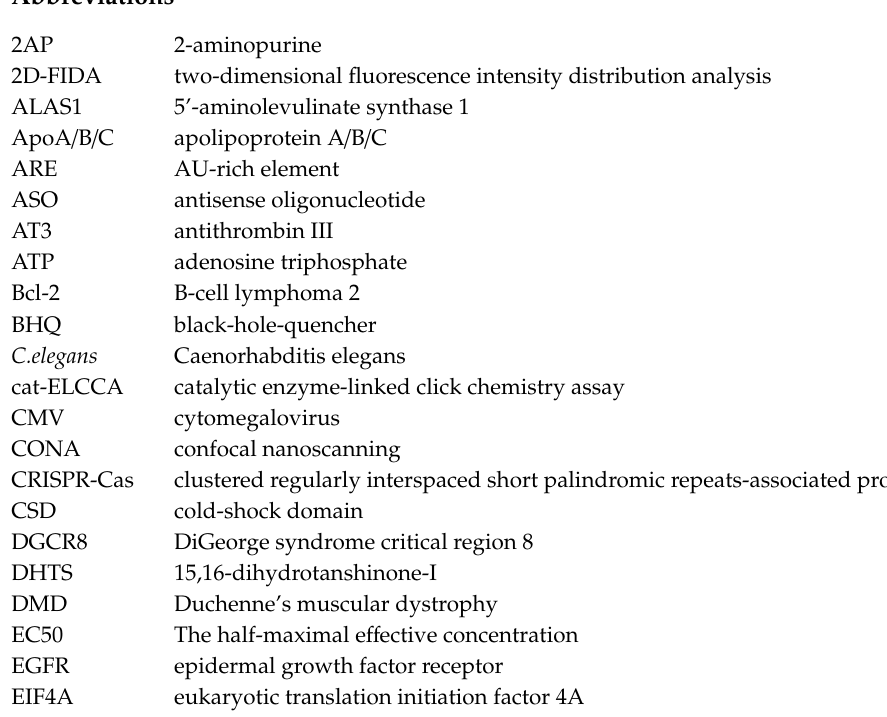
Supplementary Table S1: RNA-targeted therapies in clinical